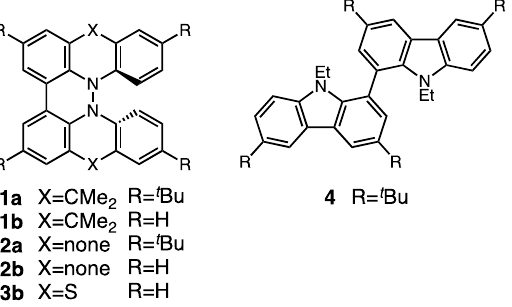
Figure 1. Hydrazine-embedded polyheterocyclic compounds 1 – 3 and reference compound 4 .